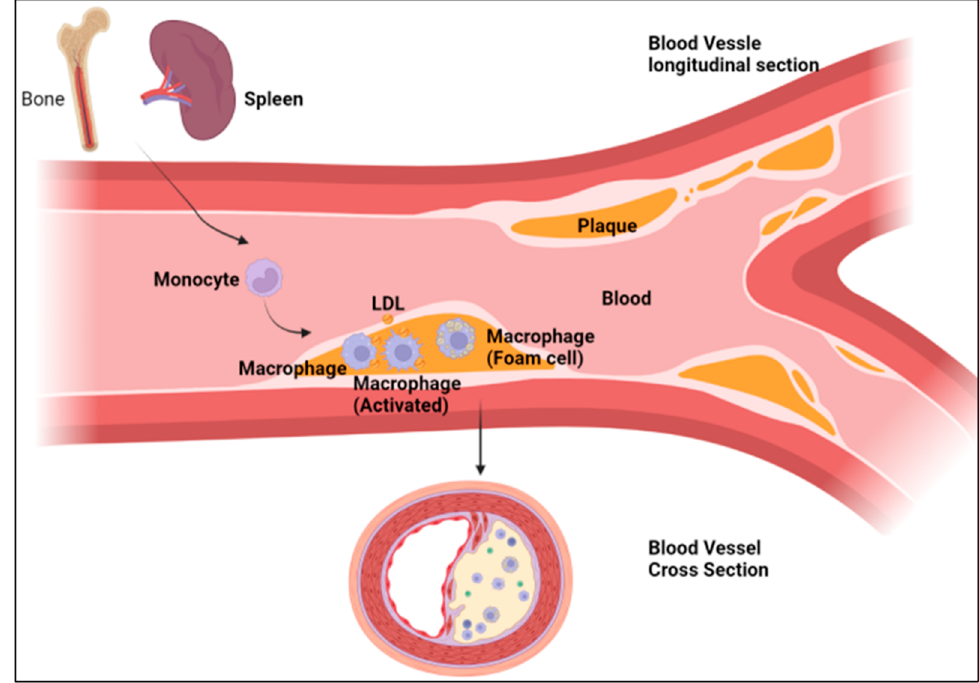
Figure 3. Schematic illustrating the role of macrophages in the development of atherosclerosis. Interest has been drawn to the interplay of long non-coding RNA (IncRNA) in macrophages and the development of atherosclerosis due to emerging research on IncRNAs that suggests they have a strong connection to the regulatory pathways of microRNAs [84,85]. While the roles of IncRNAs are still poorly understood in macrophages, the recent research has displayed promising results [86]. The macrophage- associated atherosclerosis IncRNA sequence (MAARS) was recently identified and characterized [87]. In atherosclerotic LDLR-/- mice, MAARS was discovered to be a regulator of macrophage apoptosis, efferocytosis, and plaque necrosis through a direct interaction with the RNA-binding protein HuR [87]. The expression of MAARS increases by 270-fold alongside the progression of atherosclerosis, as well as decreases by 60% with atherosclerosis regression [87]. The knockdown of MAARS resulted in a 52% decrease in lesion formation [87,88]. Furthermore, Yu et al. suggest that the lncRNA kcnq1ot1 plays a role in atherosclerosis and found that the overexpression of kcnq10t1 caused a decrease in the expression of ATP binding cassette transporter A1 (ABCA1), a transmembrane protein that mediates the efflux of cholesterol in macrophages and miR-452-3p [89]. When further examining microRNA pathways in atherosclerosis, studies have identified the lncRNA myocardial-infarction-associated transcript (MIAT) in macrophages as a key player [90– 94]. MIAT expression is elevated in the macrophages found in the necrotic core of atherosclerotic mouse models, as well as in the serum from patients with advanced atherosclerosis [95]. When MIAT was knocked down in mouse models, the macrophages displayed increased apoptotic cell clearance, reduced necrotic core formation, and increased plaque stability [95]. Moreover, another study demonstrated that MIAT expression was significantly correlated with a variety of indicators of macrophage activity, inflammatory cytokines, and growth factors, as well as vascular smooth muscle cell marker genes, a hallmark of atherosclerosis. MIAT also participated in the phenotypical switch of SMC to inflammatory macrophage-like cells that contributes to the progression of atherosclerosis and vascular inflammation [96]. The macrophage inflammatory immune response is one of the contributing factors of atherosclerotic plaque formation . Reducing the inflammatory response of macrophages has been associated with antiatherogenic properties, as displayed in the following studies.